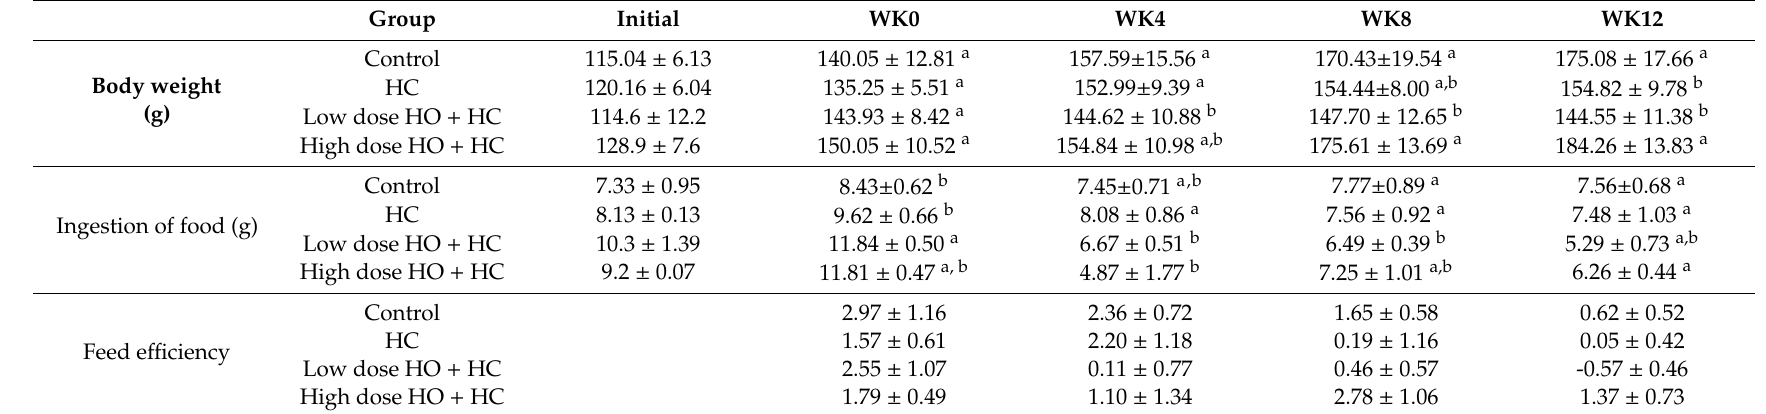
Table 3. Body weight and food ingestion of each group.